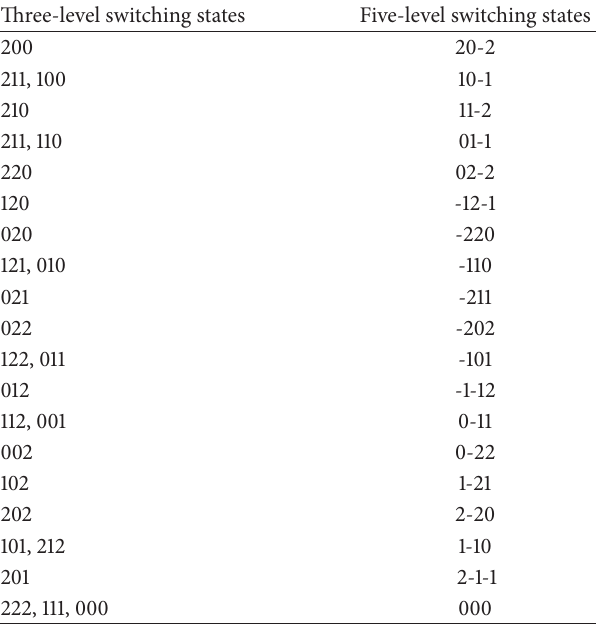
Figure 2: Space vector diagram in a five-level inverter. Table 4: Relationship between three-level switching states and five- level switching